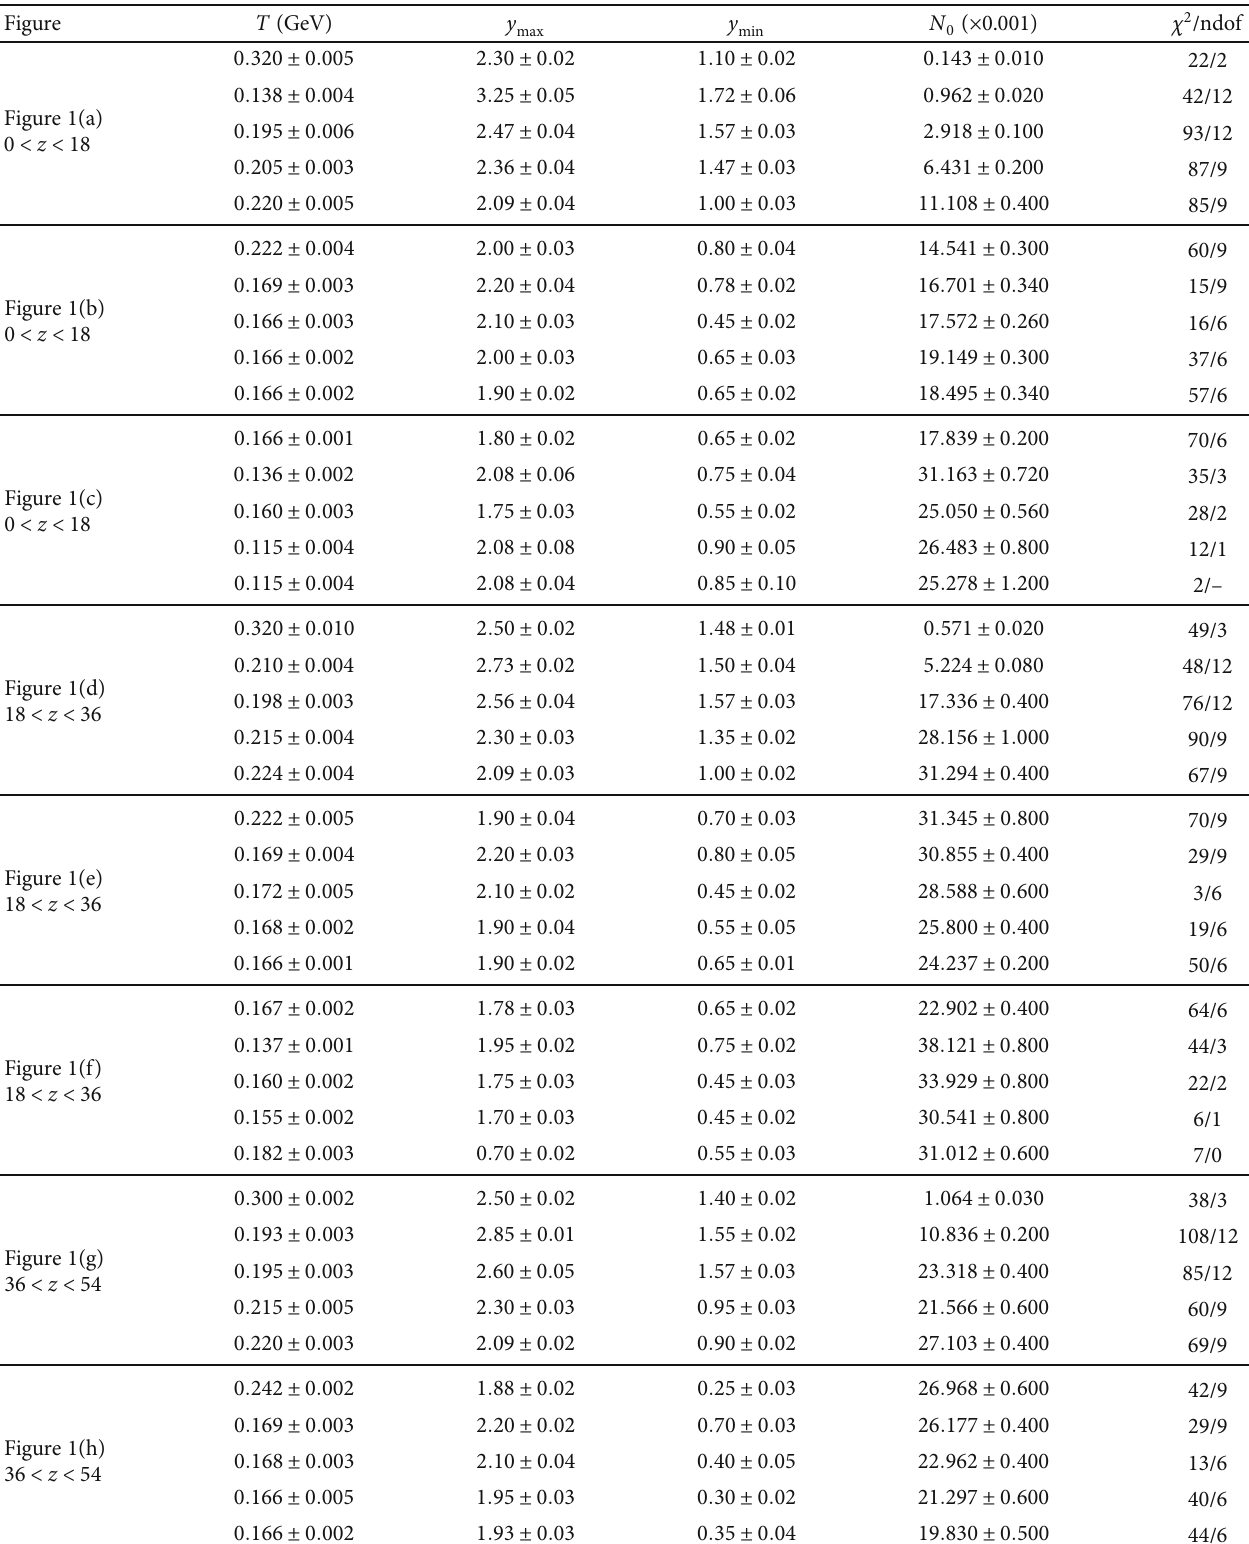
y N χ 2 , and ndof corresponding to the curves in Figure 1 in which di ff erent data are measured in di ff erent θ Table 1: Values of T , y 0 , max , min , and z ranges. In the table, z is in the units of cm and θ is not listed, which appears in Figure 1. In one case, ndof is negative which appears in terms of “–” and the corresponding curve is just for eye guiding